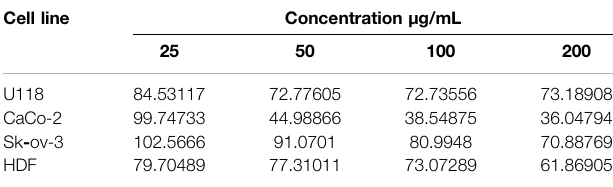
TABLE 3 | The percentage viability rates of the cell lines suppressed with AgNPs. Cell